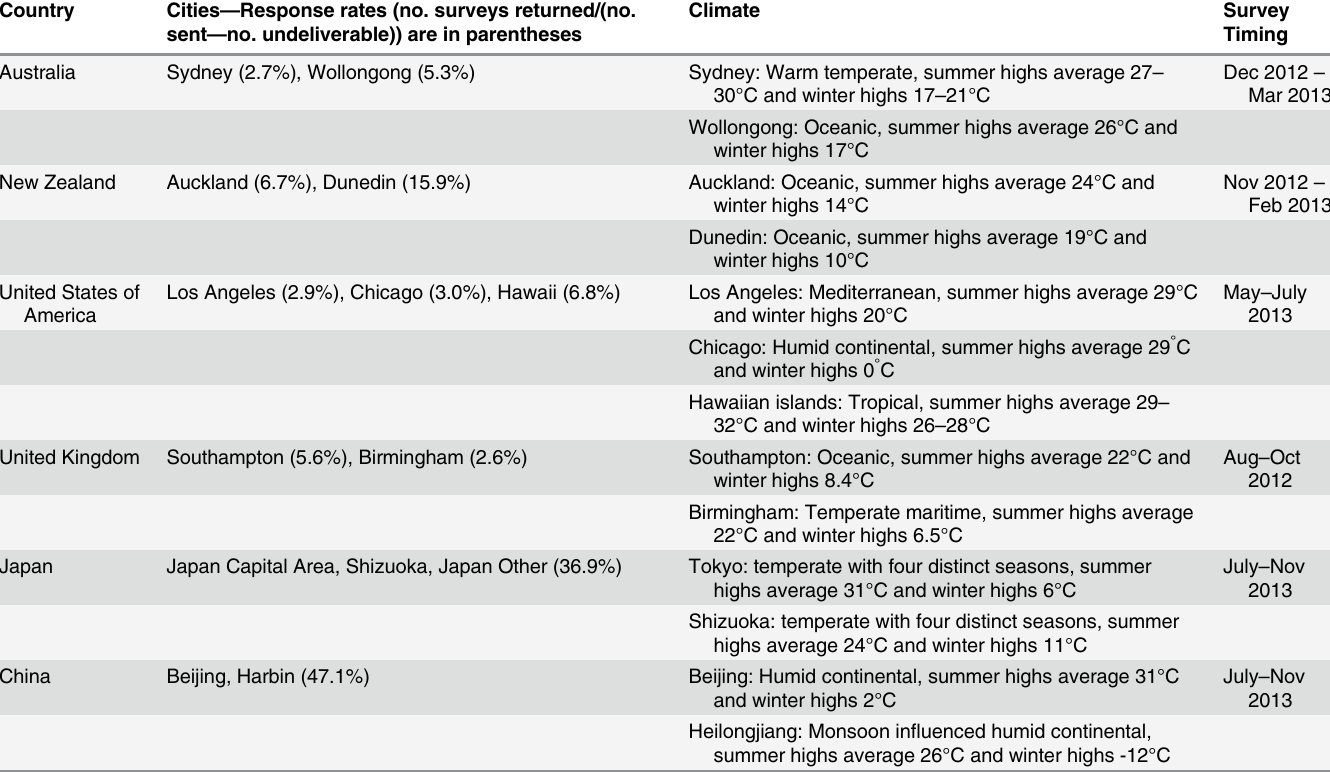
Table 1. List of participating countries and the participating cities from each country, with details of local climate, survey timing and response rates. Country Cities — Response rates (no. surveys returned/(no. sent — no. undeliverable)) are in parentheses